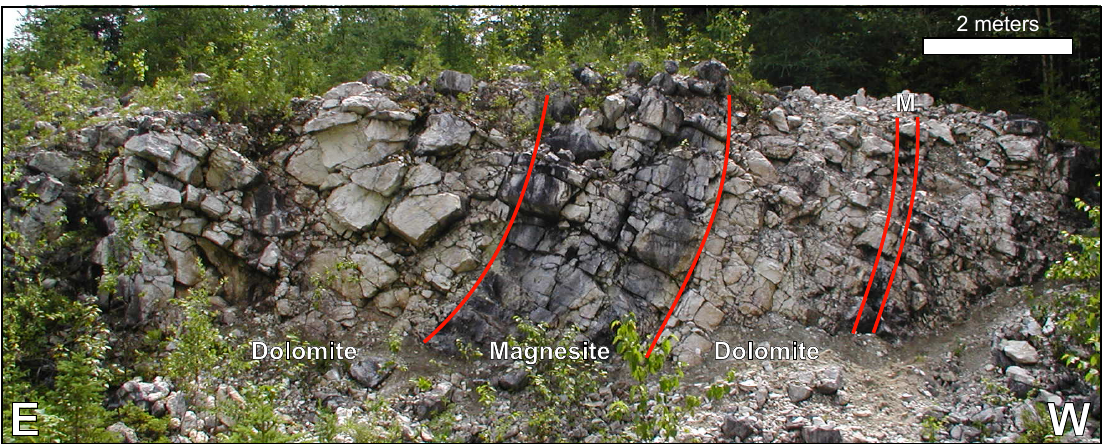
Figure 3. Geology of the south wall of the Dobbie open-pit mine, showing the remaining magnesite ore body in 2005.